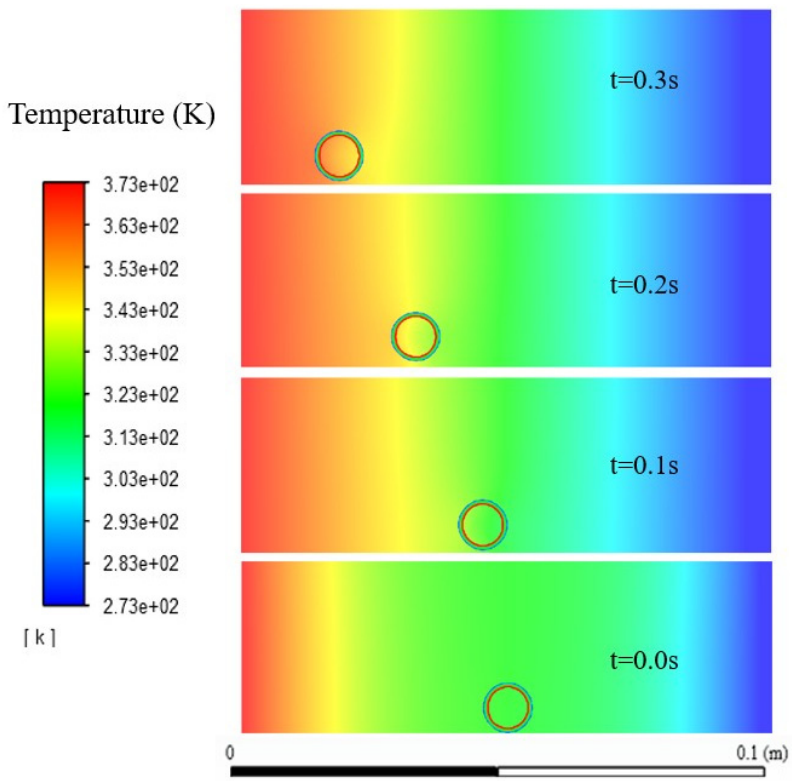
Figure 2. Transient bubble position with a radius R = 0.005 m and ∇𝑇 = 8.33 × 10 (cid:2870) K/m.